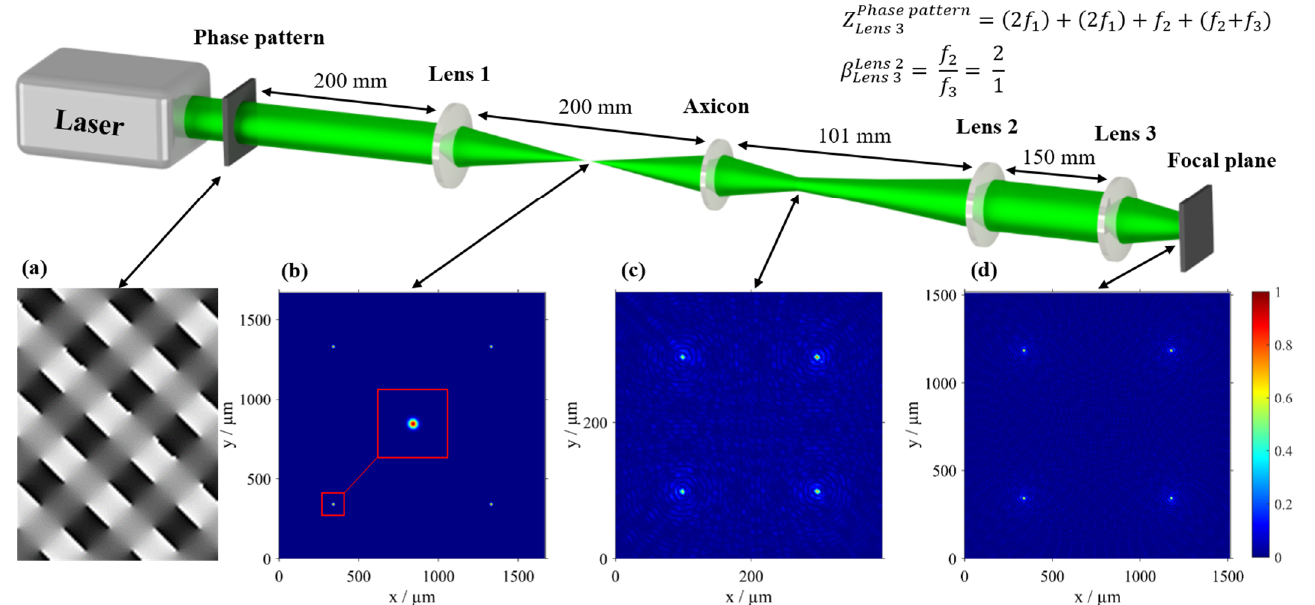
Figure 2. Schematic illustration of the simulated beam path including an SLM with a 4f-telescope and an axicon with a following imaging setup. Additionally, beside the shown phase pattern ( a ), the multi-spot beam profile in the intermediate focus ( b ), and the multi-Bessel beam after the axicon ( c ) as well as after the imaging setup ( d ) are shown. While the variable z Phase pattern formula defines the propagation distance of the beam path between the SLM and lens 3, β Lens 2 indicates the magnification of lens 2 and 3.